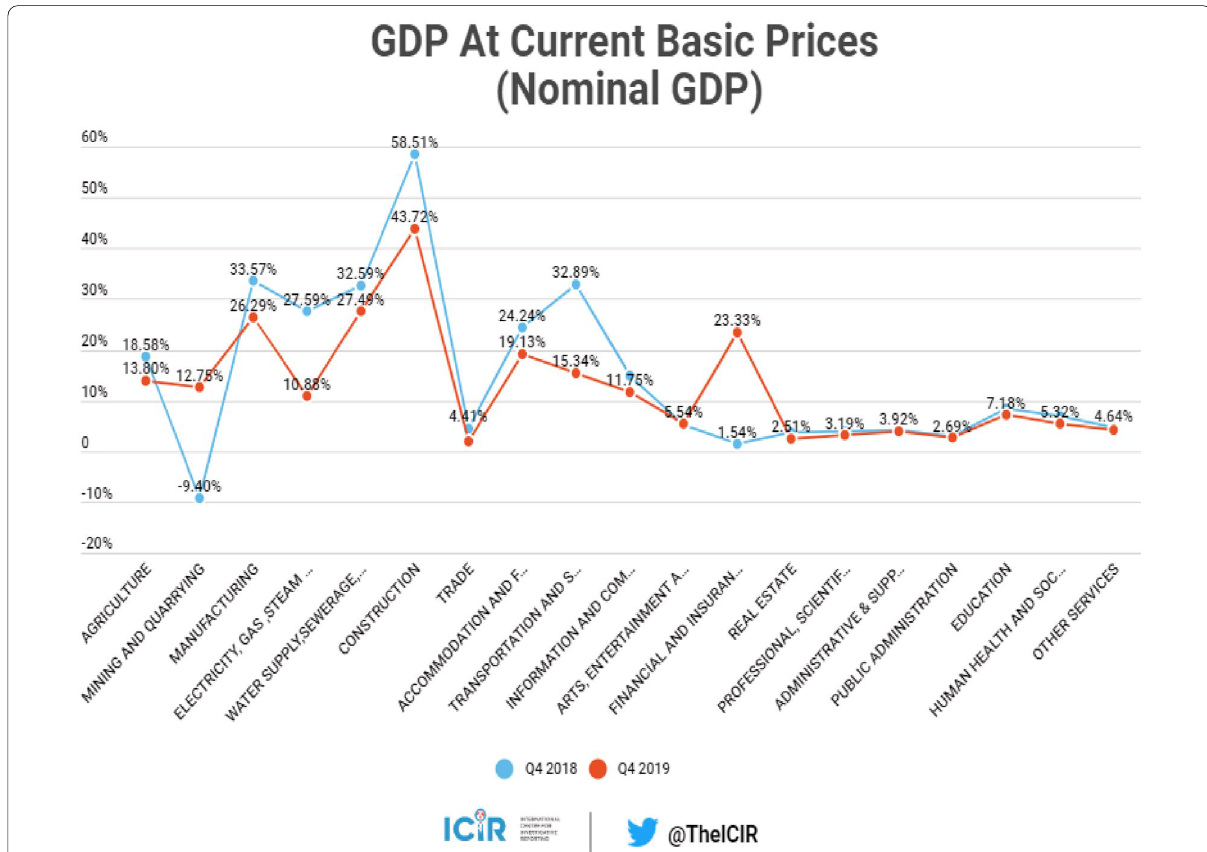
Fig. 1 Nominal income growth of sectors in Nigeria. Source : International Centre for Investigative Reporting